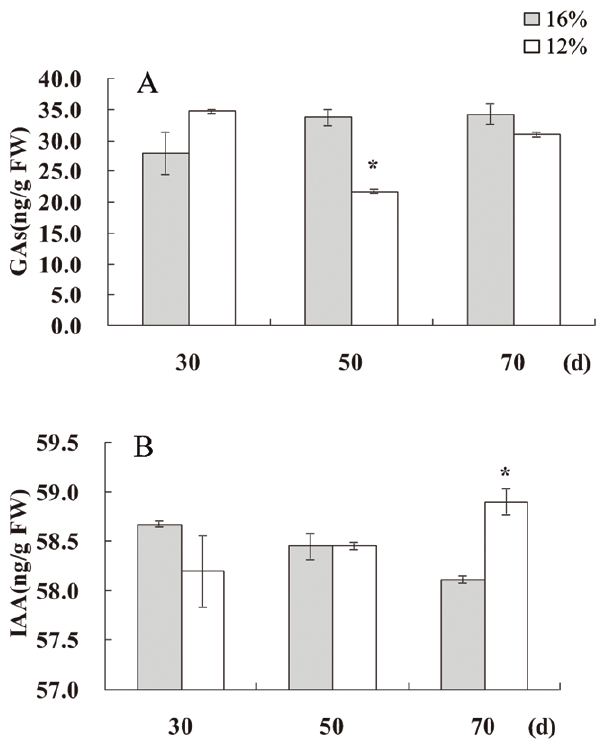
Figure 3. Effects of water deficit on endogenous GAs and IAA. The GA and IAA content of leaves of S. baicalensis grown under 16% SWC as a control and 12% SWC as a water deficit treatment. Vertical lines indicate the standard deviation of three biological replicates. Asterisks indicate a significant difference at the P , 0.05 level.